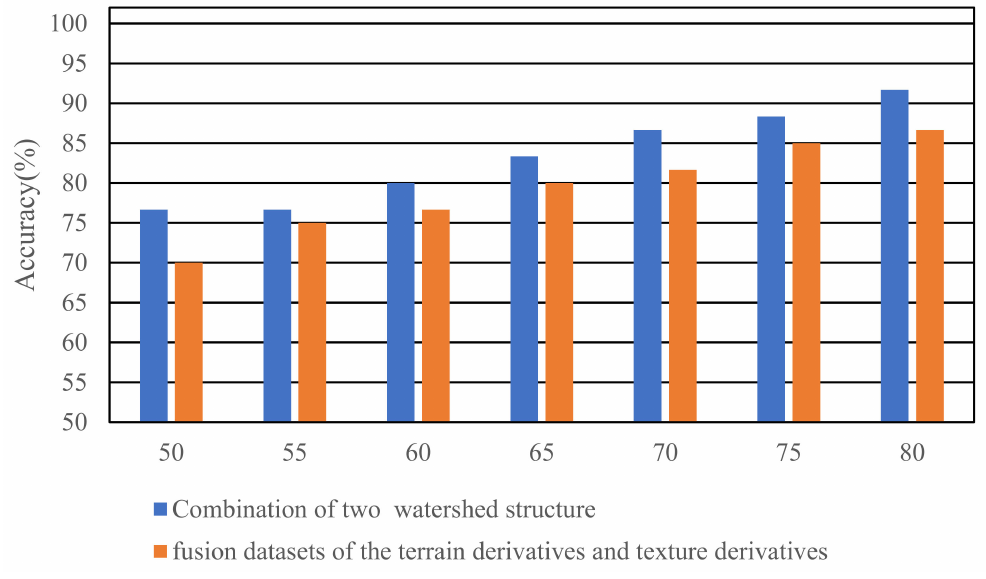
Figure 14. The overall accuracies of the two kinds of methods with the variation of the train–test dataset